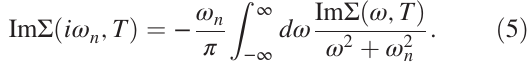
FIG. 3. (a),(b) Resistivity for ϕ ¼ 0 (solid line) and ϕ ¼ π = 6 (dashed line) for moderate and large interactions, respectively. The DMFT computation is restricted to nonmagnetic solutions, and the black ( ϕ ¼ 0 ) and red ( ϕ ¼ π = 6 ) crosses mark the magnetic transition temperature. (c) The ratio of resistivity of two phases ρ ð ϕ ¼ π = 6 Þ = ρ ð ϕ ¼ 0 Þ at different temperatures and